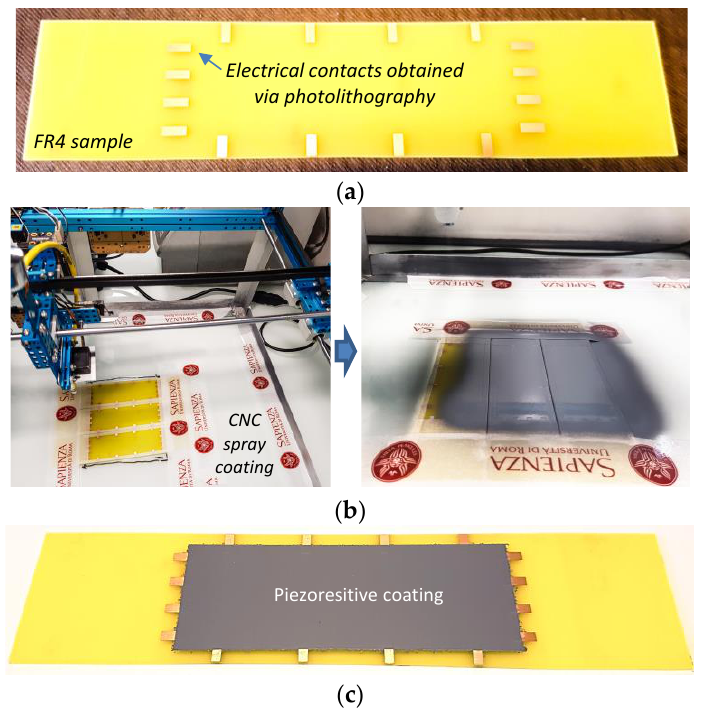
Figure 6. Picture of an FR4 rectangular sample with copper pads before the coating process ( a ); CNC x-y plotter equipped with an airbrush during the spray deposition of GNP-filled paint ( b ); FR4 sample with the piezoresistive coating ( c ).